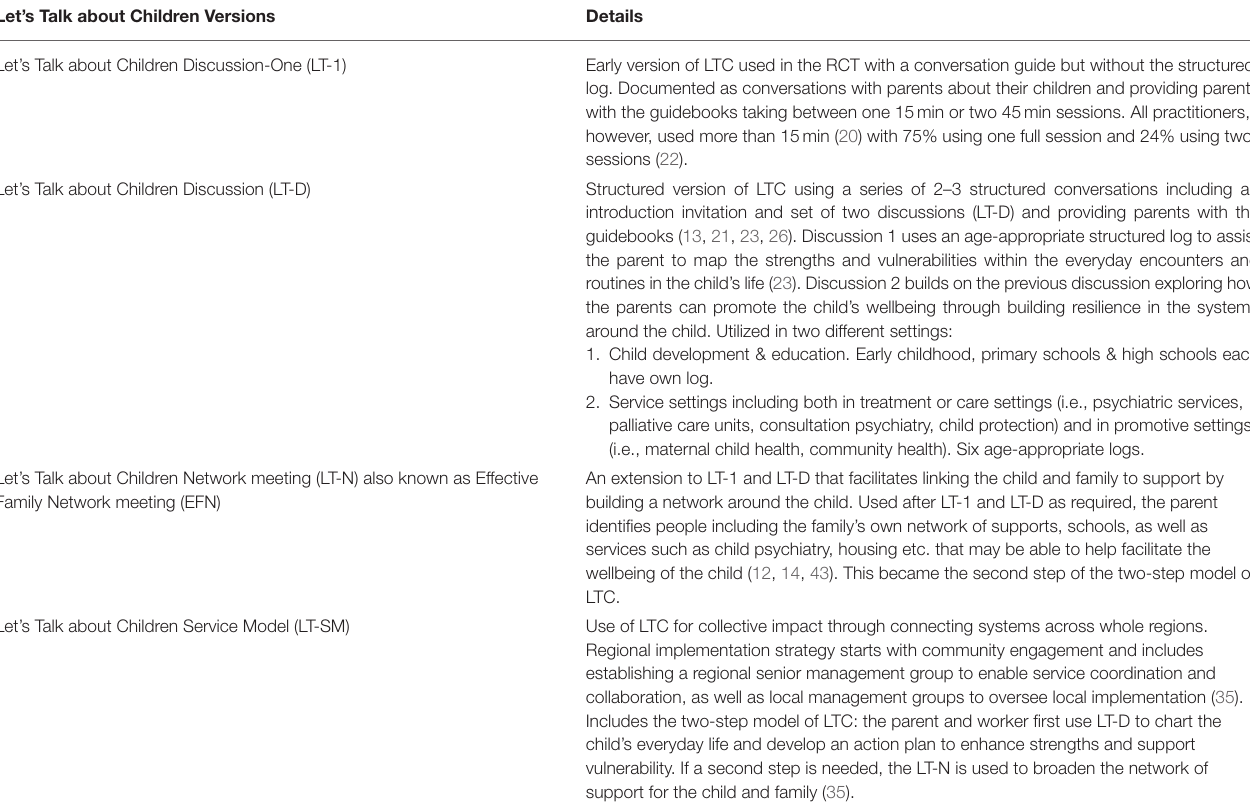
TABLE 2 | Descriptions of the versions of